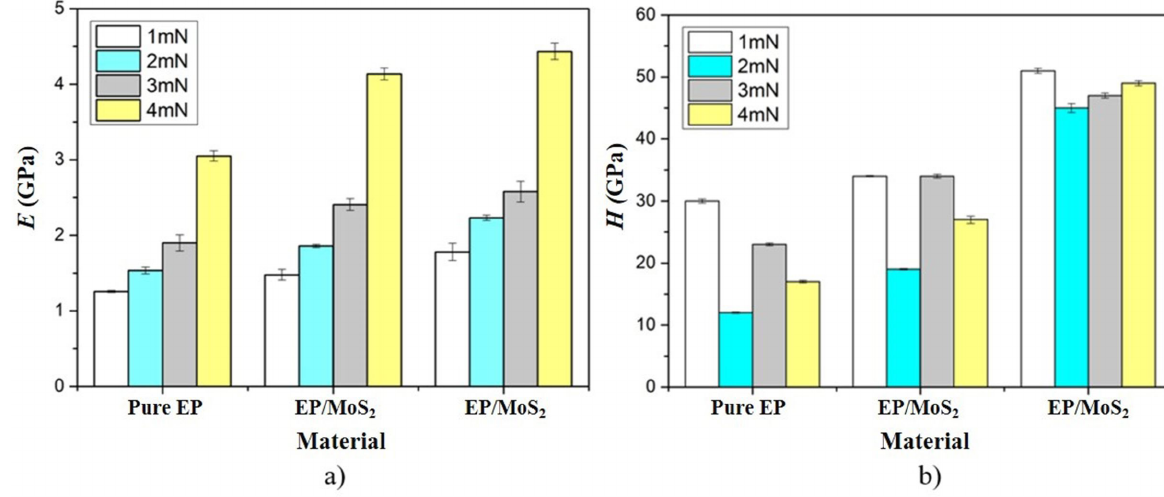
Figure 9: Histograms of a) elastic modulus; b) hardness under different indentation loads